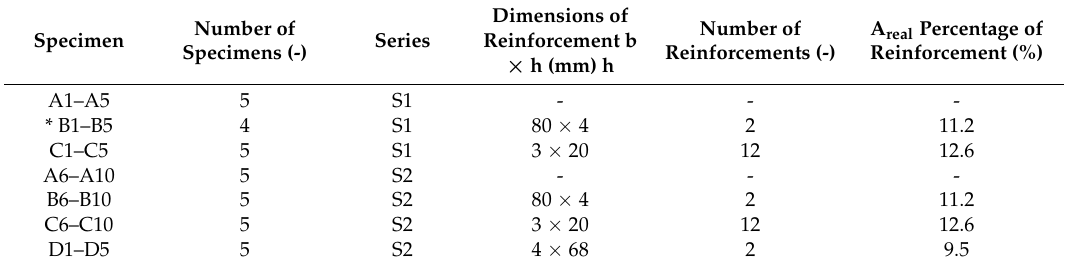
Table 3. Characteristics of the tested